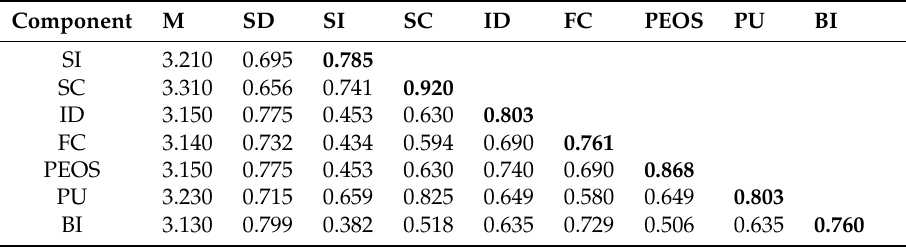
Table 2. Discriminant Validity (The construct mean/standard deviation are noted by the construct; all constructs pass the validity test).